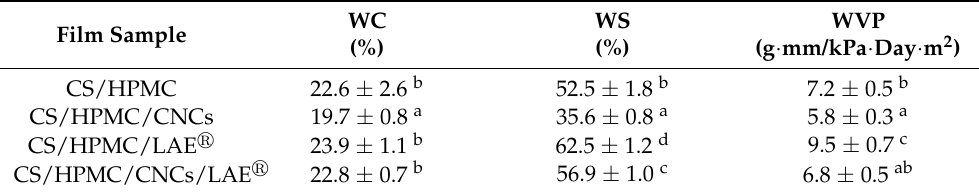
Table 5. Water content (WC), water solubility (WS), and water vapor permeability (WVP) of films based on chitosan/hydroxypropyl methylcellulose blend (CS/HPMC, 2% w / v ) as the control and those reinforced with cellulose nanocrystals (10% w / w of biopolymer) and/or lauroyl arginate ethyl (cid:114) (LAE , 5% w / w of